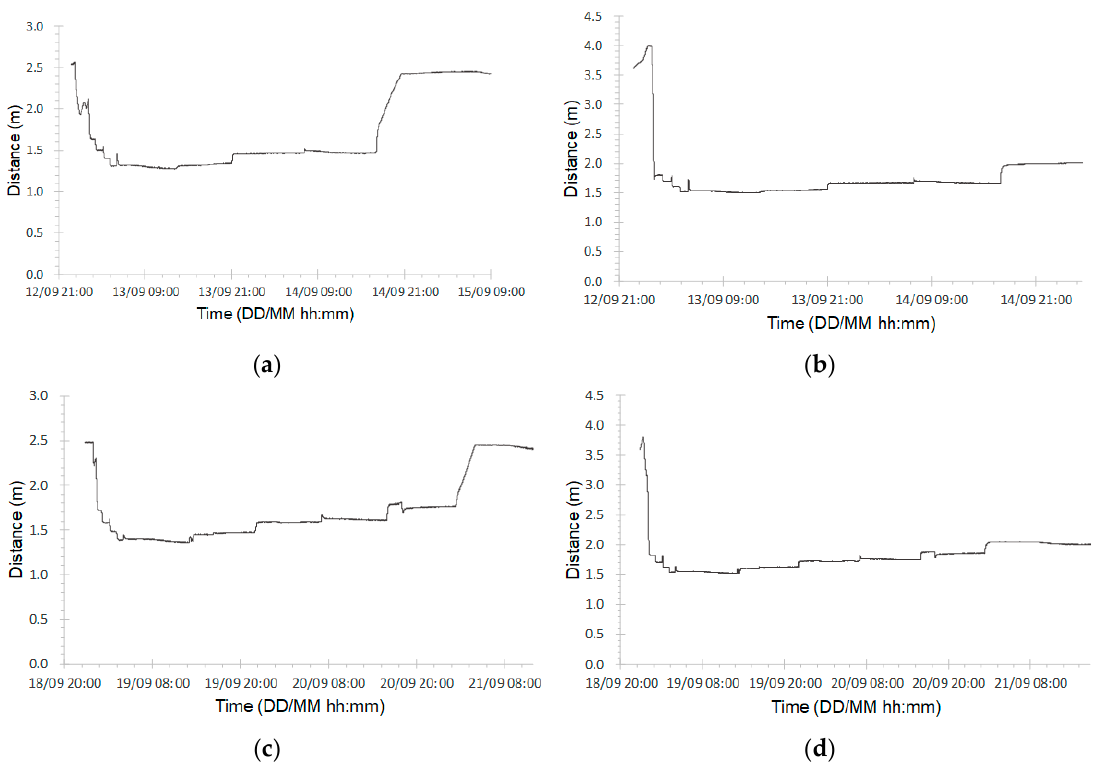
Figure 8. The data set after the smoothing process using EWMA. ( a ) Case of hydrograph 1— downstream bridge; ( b ) case of hydrograph 1—upstream weir; ( c ) case of hydrograph 2— bridge; ( b ) case of hydrograph 1—upstream weir; ( c ) case of hydrograph 2—downstream bridge; ( d downstream bridge; ( d ) case of hydrograph 2—upstream weir.